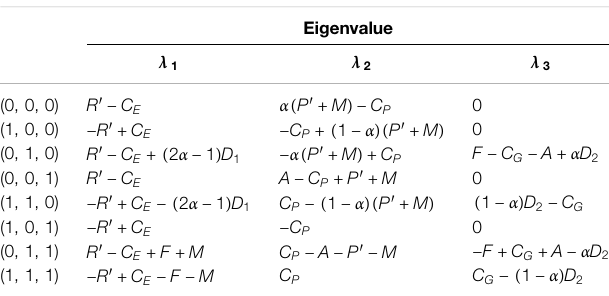
TABLE 3 | ESS and eigenvalues of the dynamic